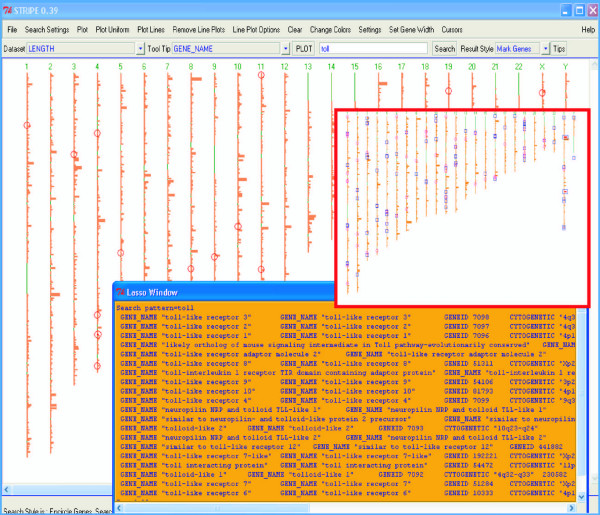
Search functionality in STRIPE. It is possible to perform a free-text or a regular expression based search on the entire genome and identify genes of interest. It is also possible to perform as many searches on a plot and mark up different search results in different colors and shapes. Shown in the figure are search results for the keyword "toll" in the human genome. Shown in the inset is how two different searches may be highlighted in the same plot (blue rectangle: keyword interleukin, red oval: keyword interferon).